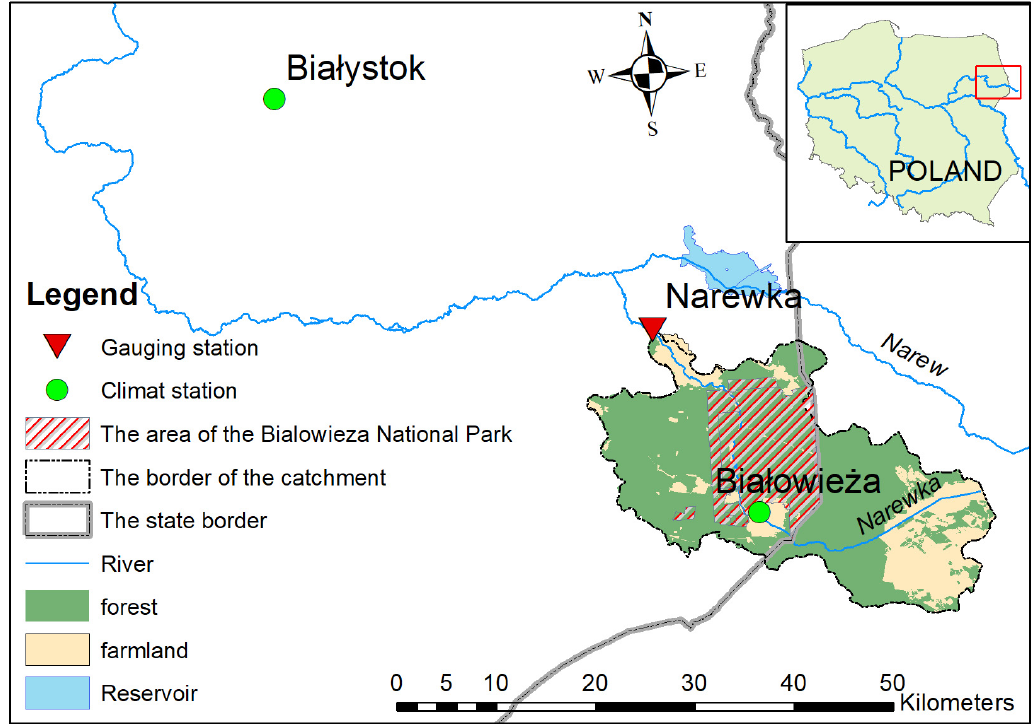
Figure 1. Locality map of the Narewka catchment and gauging station.